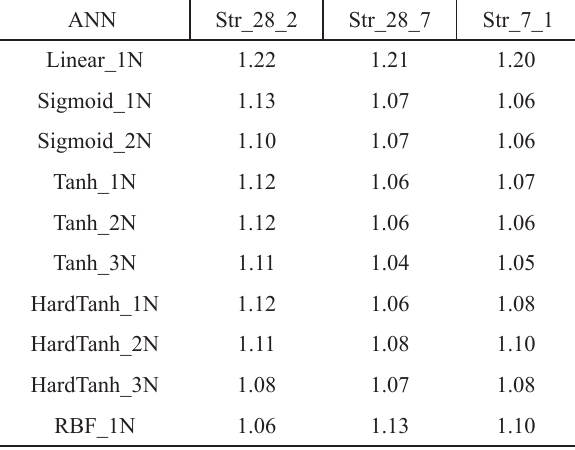
Table 5 – Ratio of Maximum to Minimum RMSE